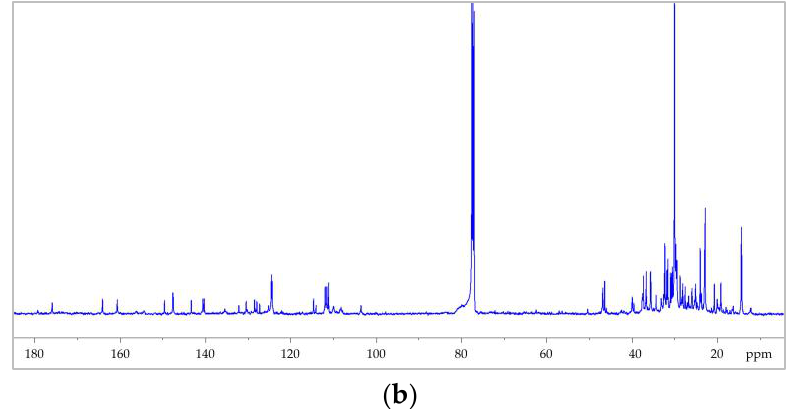
Figure 5. NMR spectra (500 MHz) of inflorescence extracts dissolved in CDCl3 recorded at 298K. ( a ) 1 H NMR spectrum recorded using zg30 Bruker standard pulses sequence; for each experiment, 128 FIDs were accumulated using a spectral width of 14.00 ppm and a relaxation delay of 5 s. ( b ) 13 C-